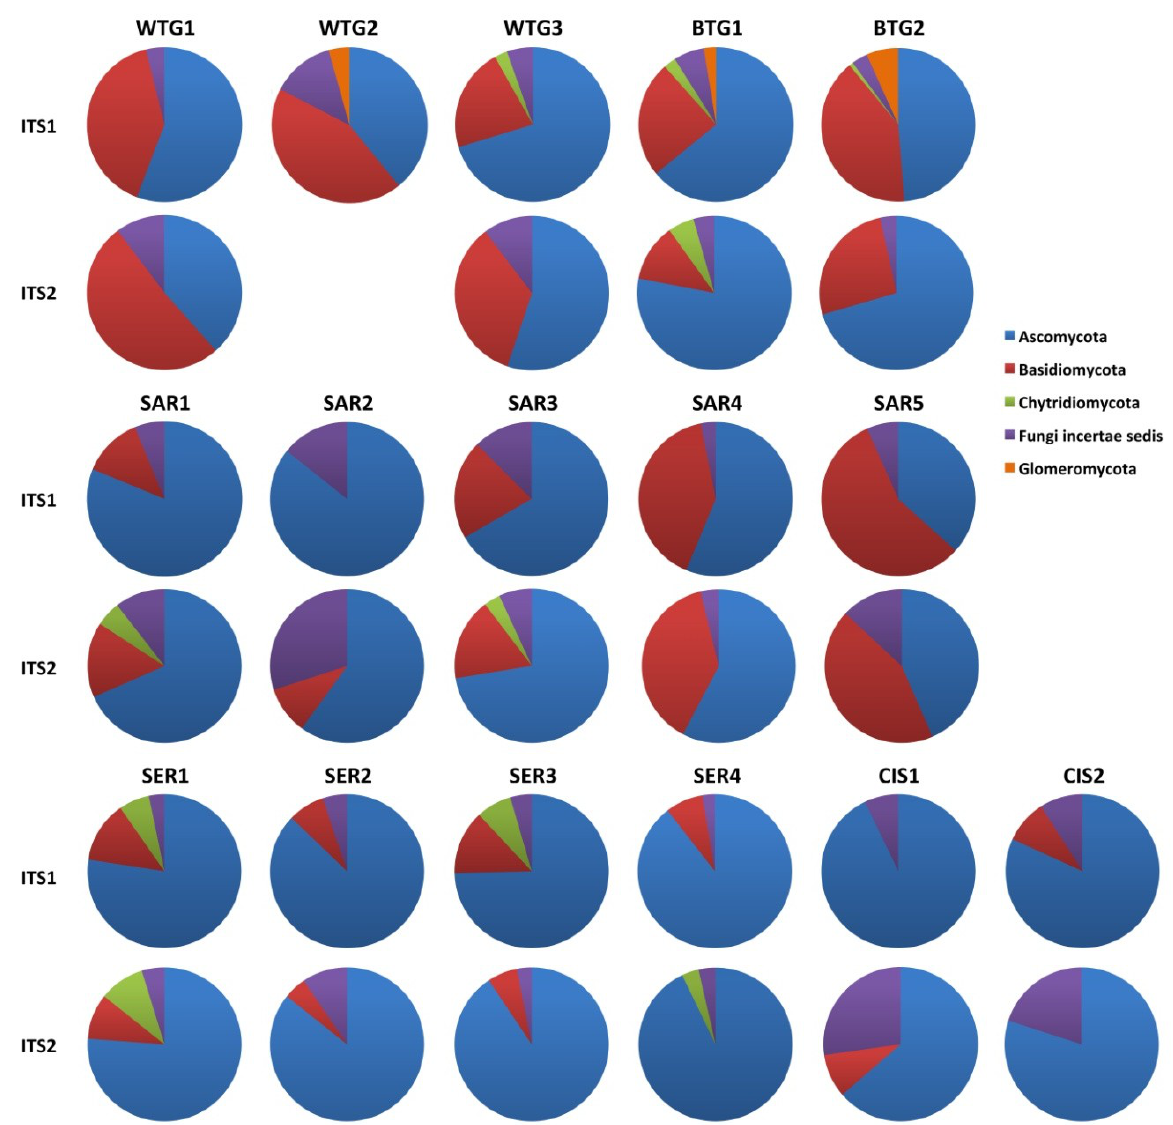
Figure 4. Proportion of the ITS1 and ITS2 fungal OTUs assigned to different fungal phyla (according to the NCBI Taxonomy) within each sample (following rarefaction to even sequencing depth: 254 and 158 ITS1 and ITS2 sequences per sample, respectively). WTG: white truffle grounds; BTG: black truffle grounds; SAR: Sardinian soils; SER: serpentinitic substrate samples; CIS: contaminated industrial